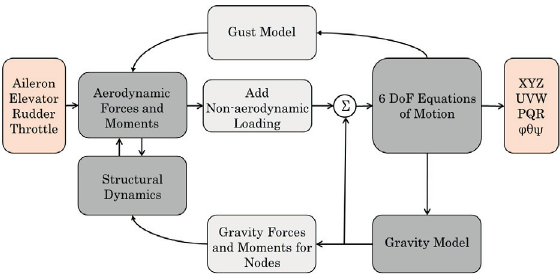
Fig. 2. Structure of the CA 2 LM framework